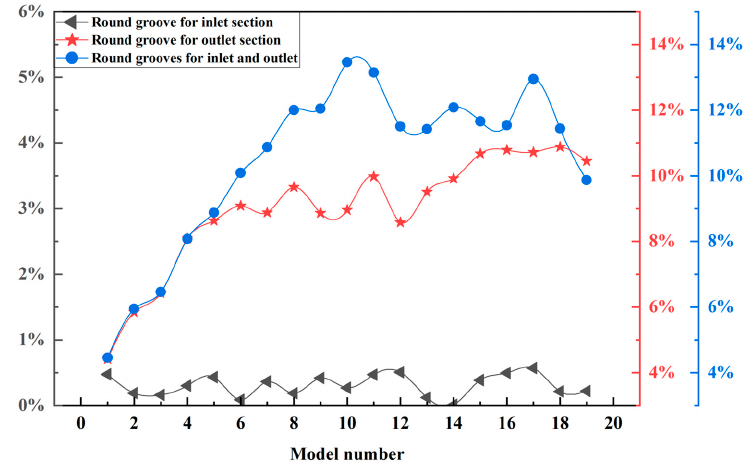
Figure 11. Velocity increase rate of the BSCN.